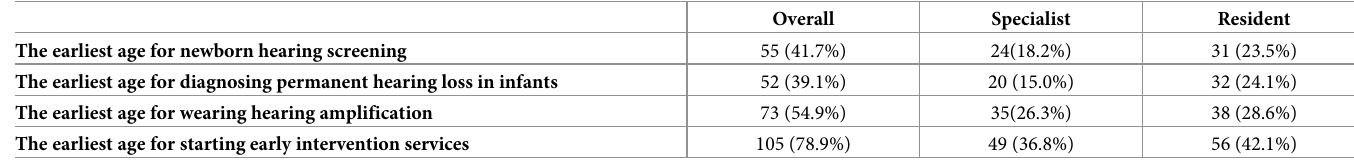
Table 2. The percentage of family physicians correctly answered the ages at which early identification of hearing loss procedures should be conducted. Overall Specialist